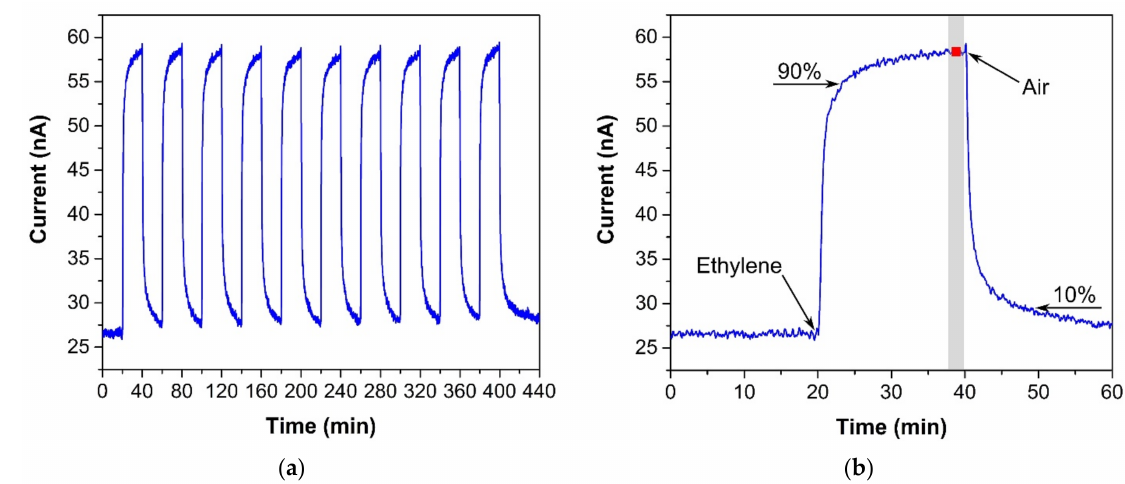
Figure 3. ( a ) Sensor response to ten consecutive ethylene exposures (300 ppm), ( b ) Sensor response to one ethylene exposure with details for determining the response/recovery time and repeatability. Conditions: 22 ◦ C, 40%RH, 101.325 kPa, 1 L/min.